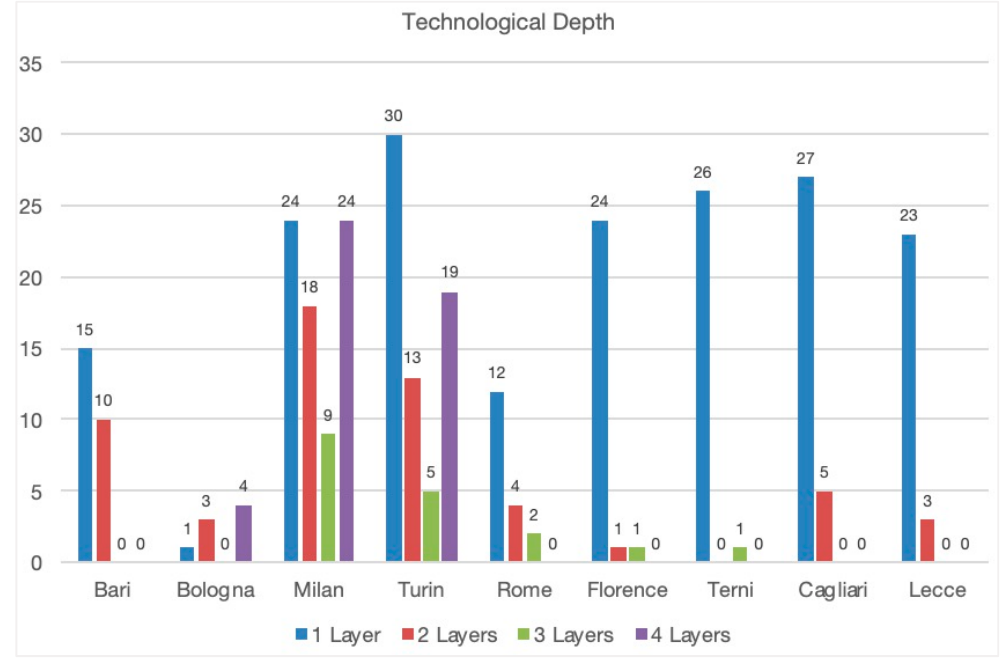
Figure 8. Overview of technological depth for single Smart city.